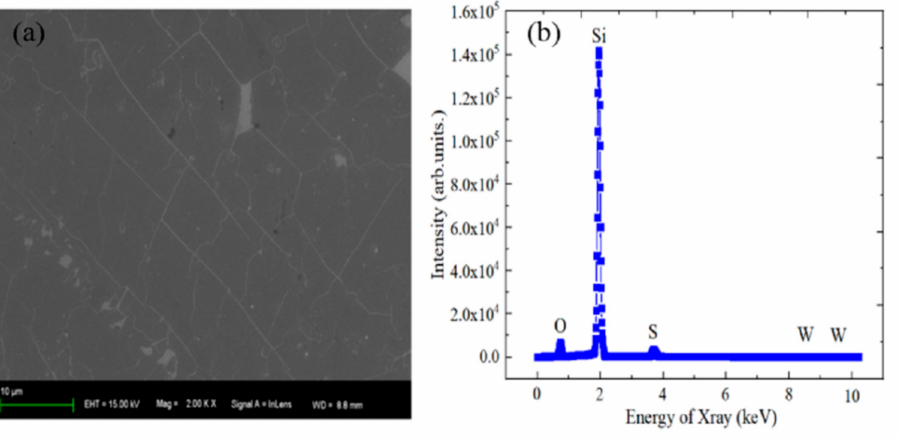
Figure 2. ( a ) SEM image and ( b ) EDX spectrum of WS 2 material.